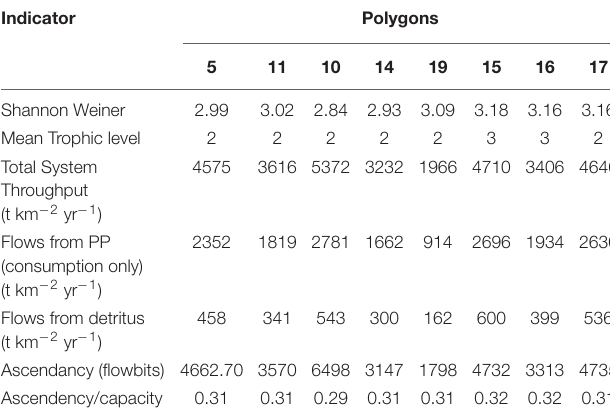
TABLE 2 | Indicator values from the eight spatial polygons for the calibration simulation of CASM.